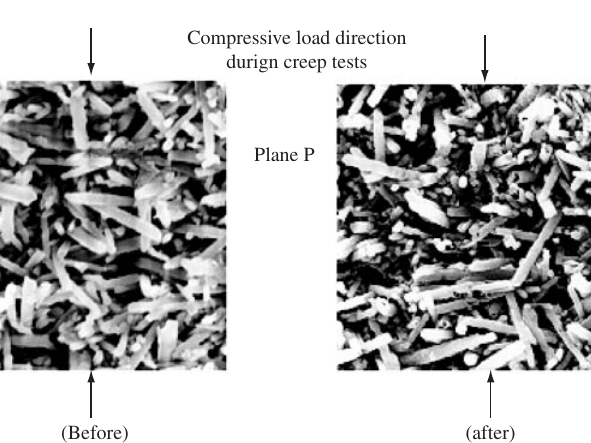
Figure 5. Reorientation of the β -Si SNCAL 20 and SNCAN 5 as a function of the exposure time to the creep deformation.